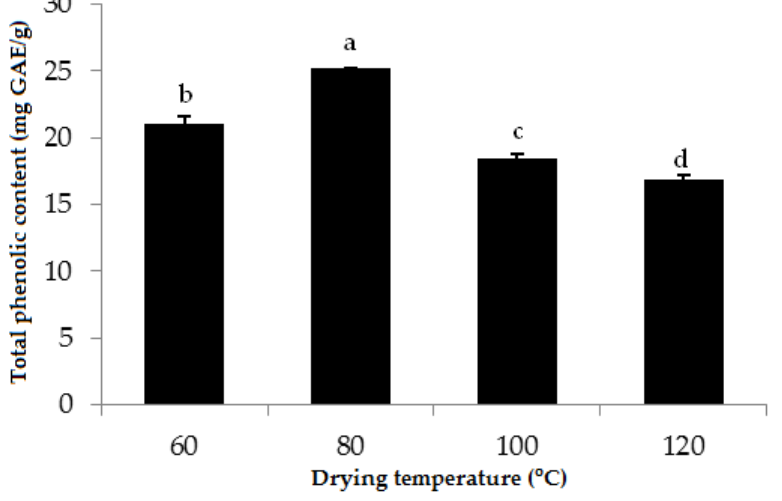
Figure 2. Effect of different drying temperatures on total phenolic content of dried Roselle. ( a – d ) Different letters express significant differences among values.